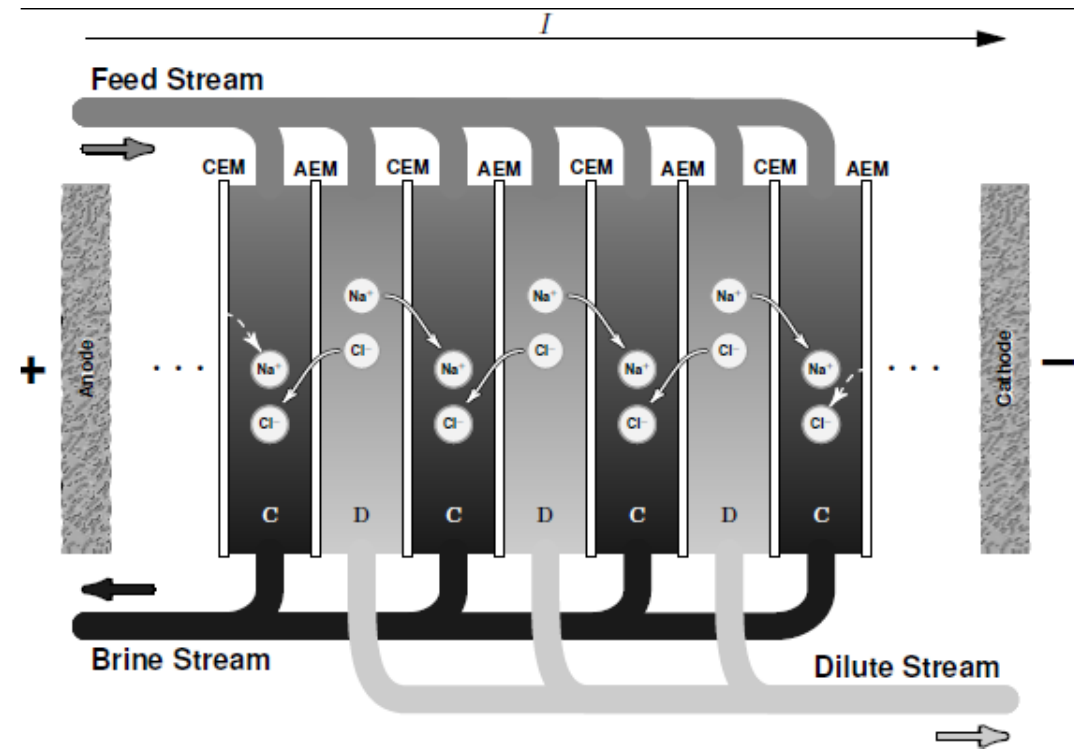
Figure 2. A schematic diagram of electrodialysis (ED) where C is the concentrate compartment and D is the dilute compartment, .